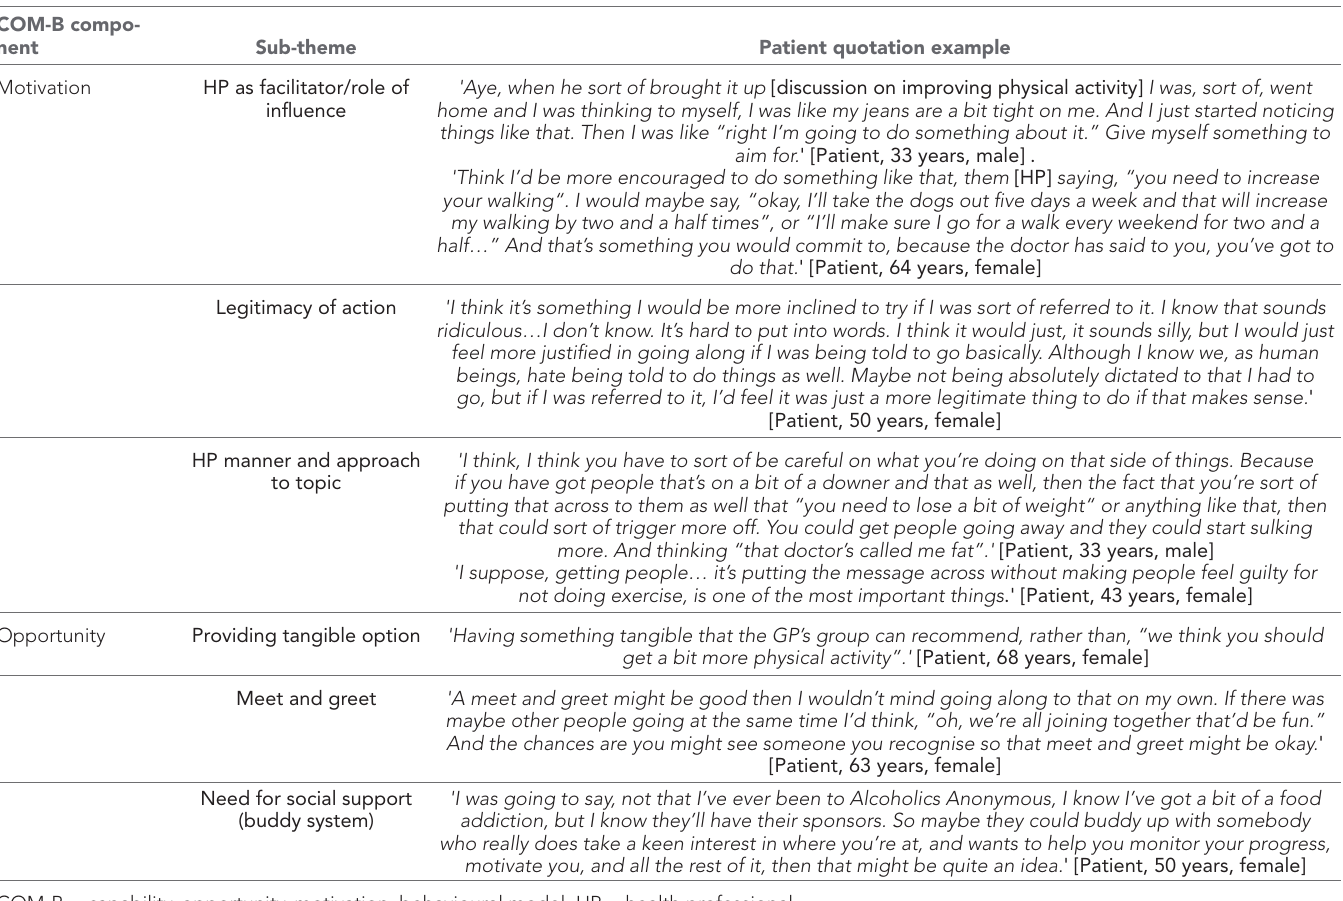
Table 3 Emergent COM- B components, sub- themes, and quotations from patient analysis